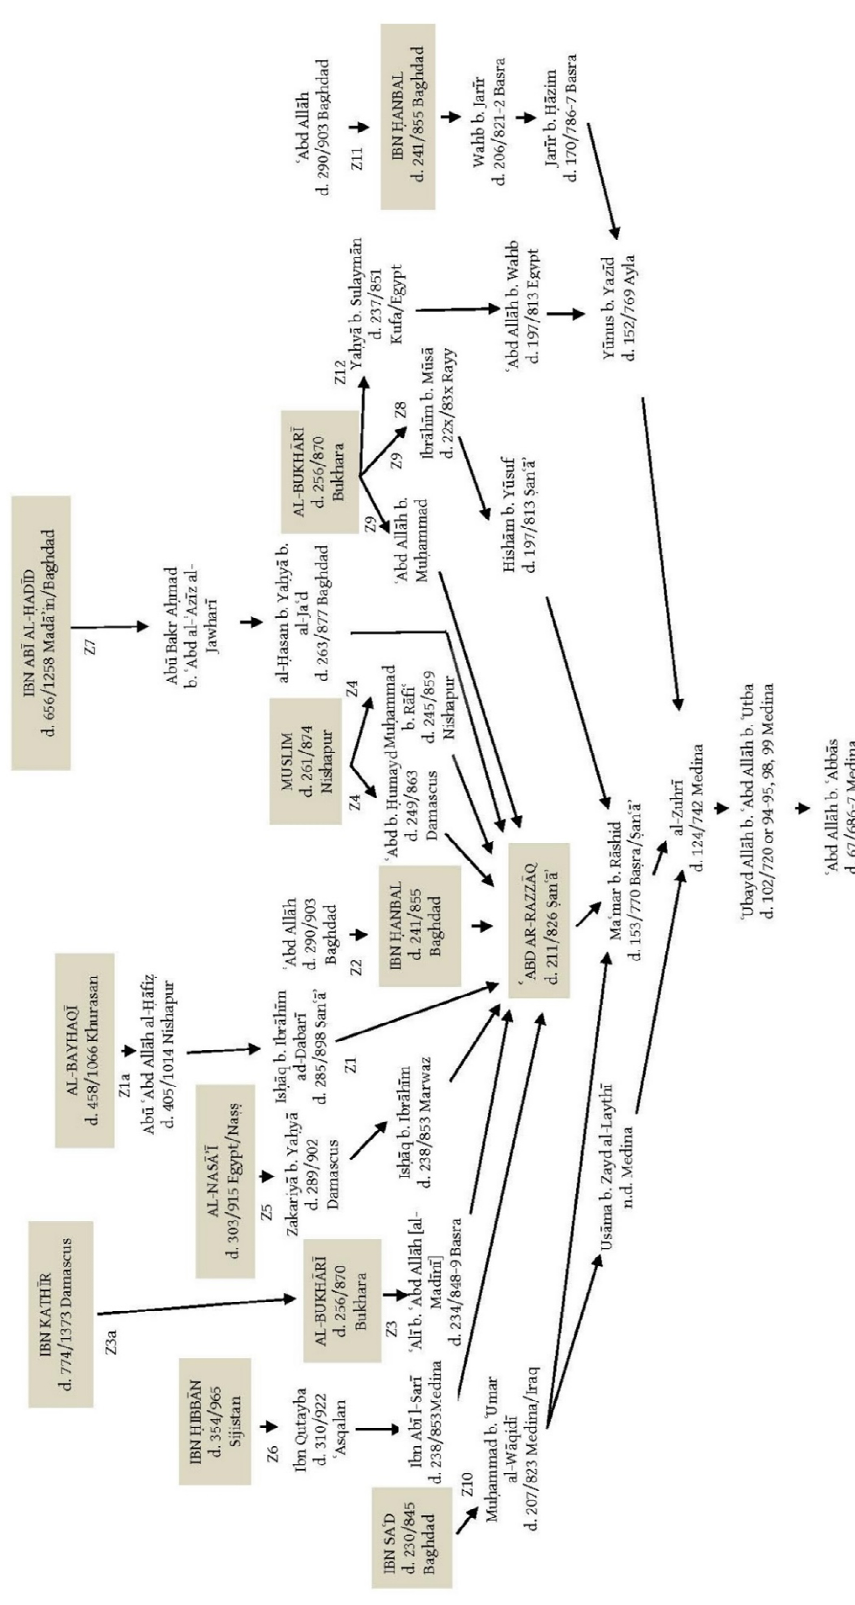
Figure A2. Isn ā d bundle of the Ibn ʿ Abb ā s traditions from al-Zuhr ī . Figure A2. Isn¯ad bundle of the